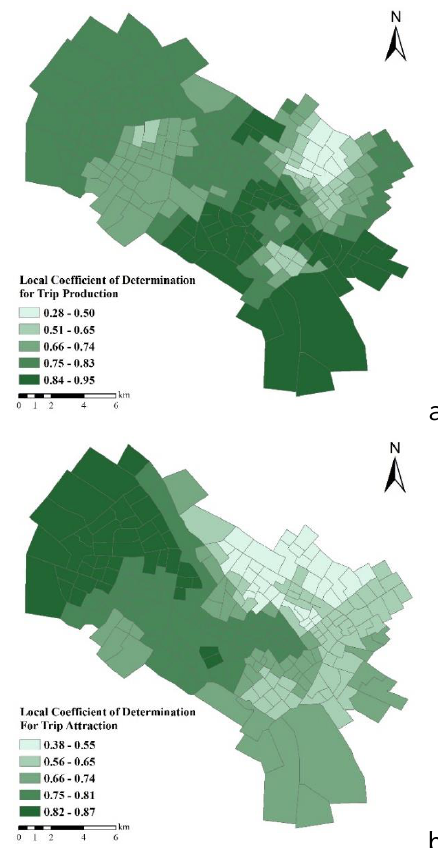
Figure 4. Local coefficients of determination for a) trip production and b) trip attraction